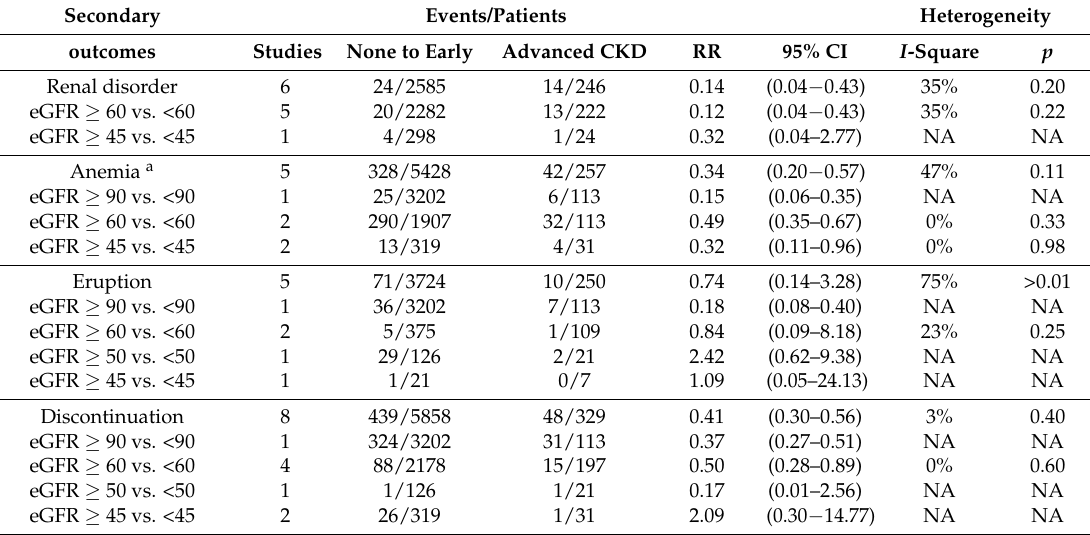
Table 3. Summary of the meta-analysis for secondary outcomes (side effects and